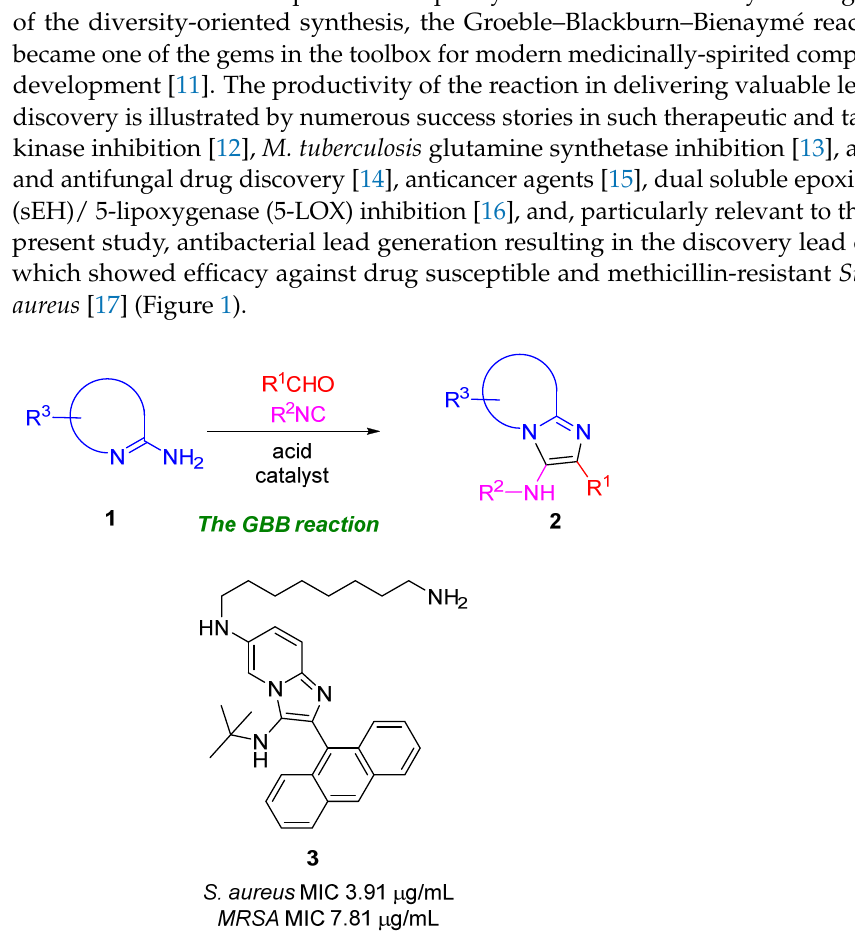
Figure 1. The Groeble–Blackburn–Bienaymé (GBB) reaction and relevant GBB reaction-derived antibacterial lead compound 3 .